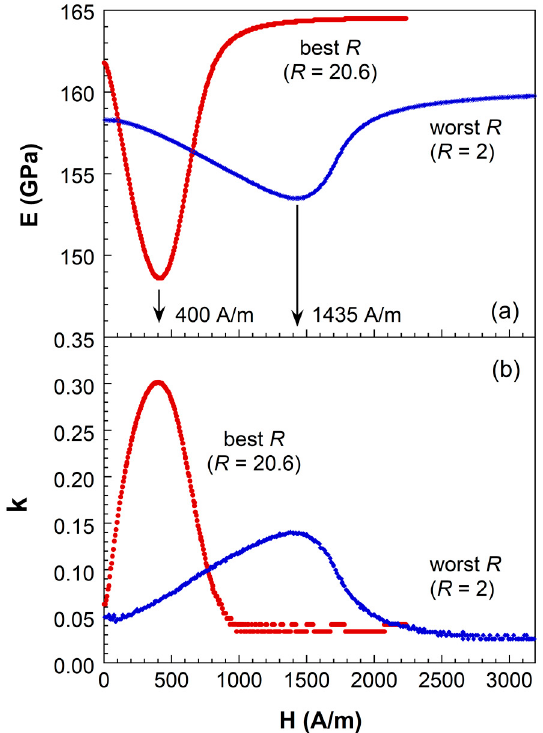
Figure 2. ( a ) ∆ E e ff ect and ( b ) magnetoelastic coupling coe ffi cient measured for strips of Metglas ® Figure 2. ( a ) Δ E effect and ( b ) magnetoelastic coupling coefficient measured for strips of Metglas ® 2826MB3 with the highest ( R = 20.6) and the lowest ( R = 2) R 2826MB3 with the highest ( R = 20.6) and the lowest ( R = 2) R value.